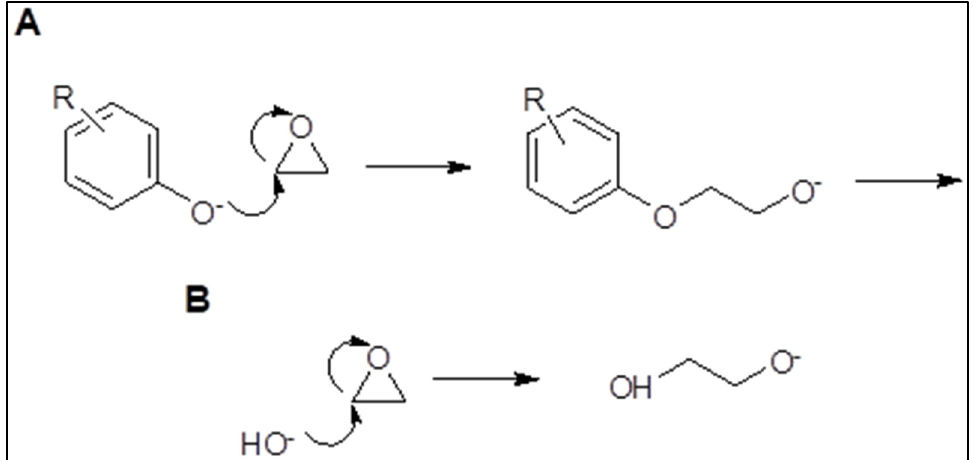
Figure 4. ( A ) Formation of majorethoxylate anion (R = C12H25); ( B ) formation of minor by-product